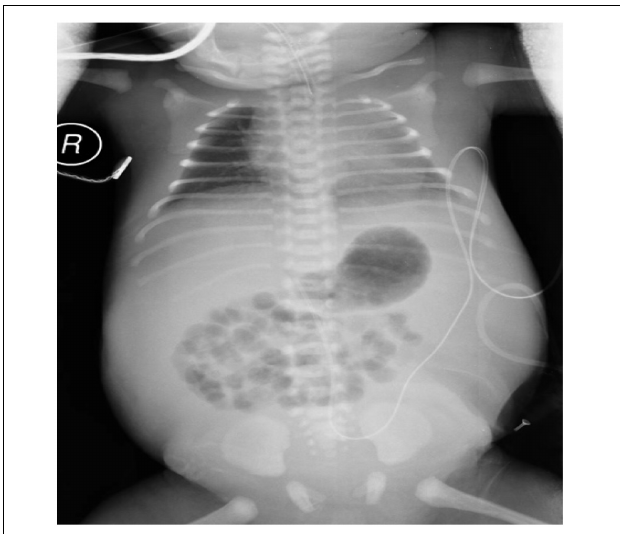
FIGURE 1 | Radiograph of the neonate’s chest and abdomen showing generalized edema and tense distended abdomen with a mount of